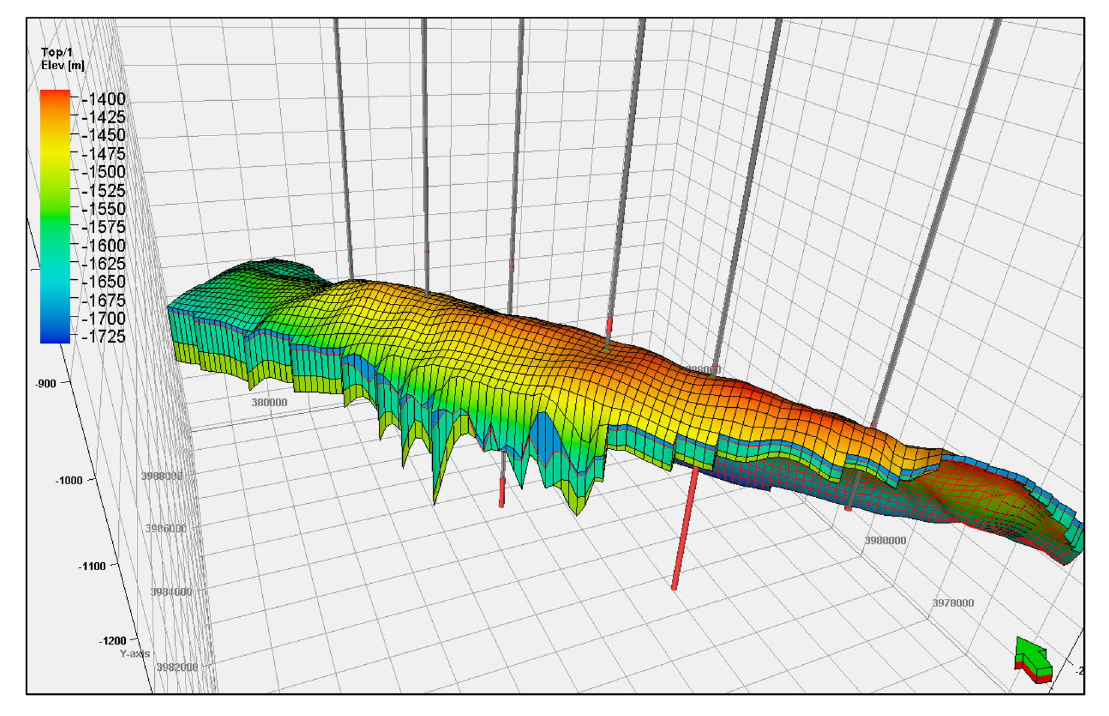
Fig. 3 3D Geo-cellular gridding model